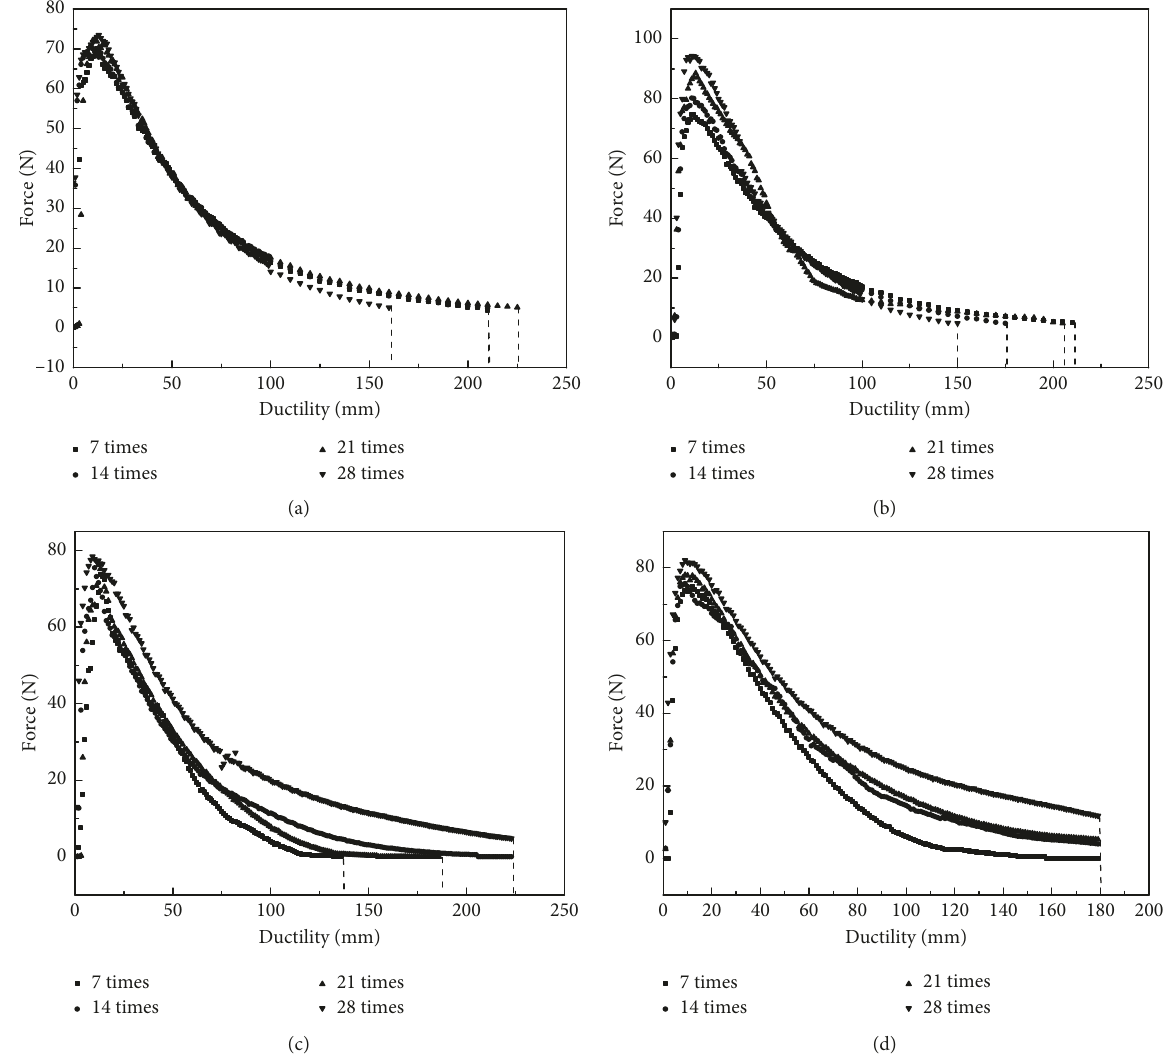
Figure 6: Force ductility test results: (a) 0% Na 2 SO 4 , (b) 2.5% Na 2 SO 4 , (c) 5% Na 2 SO 4 , and (d) 10% Na 2 SO 4